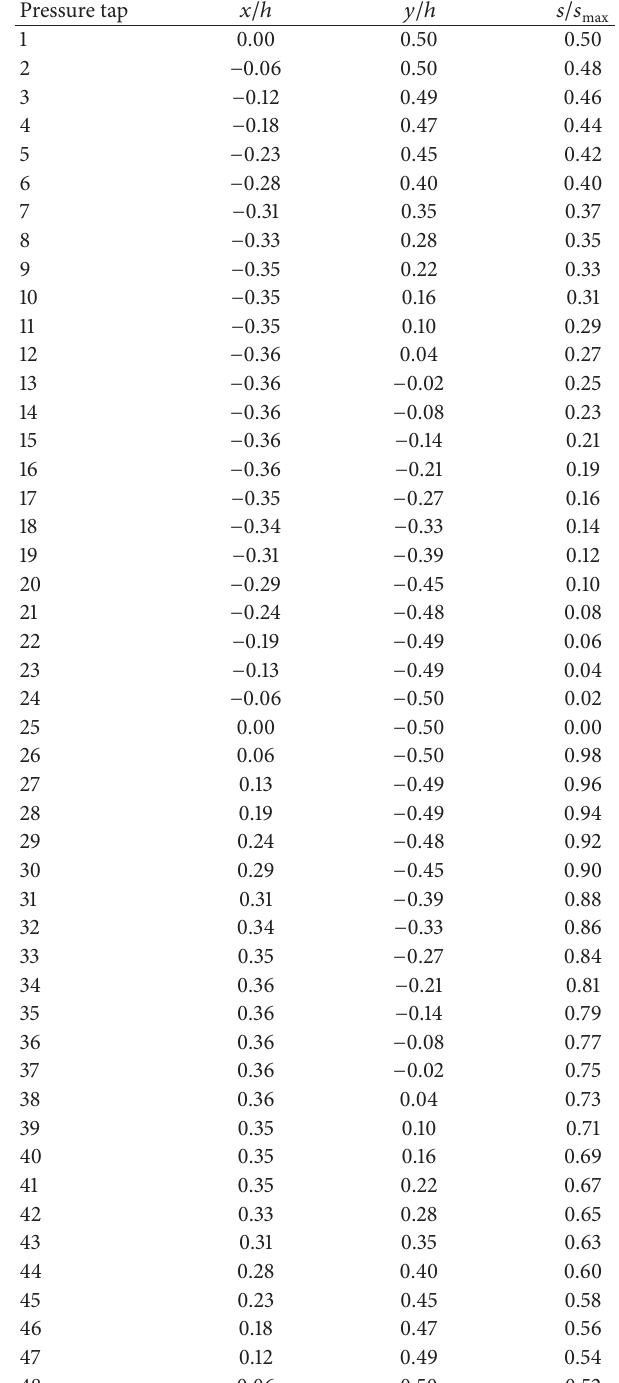
Table 1: Nondimensional coordinates regarding each pressure tap installed on the model surface. The reference axes are shown in Figures 1 and